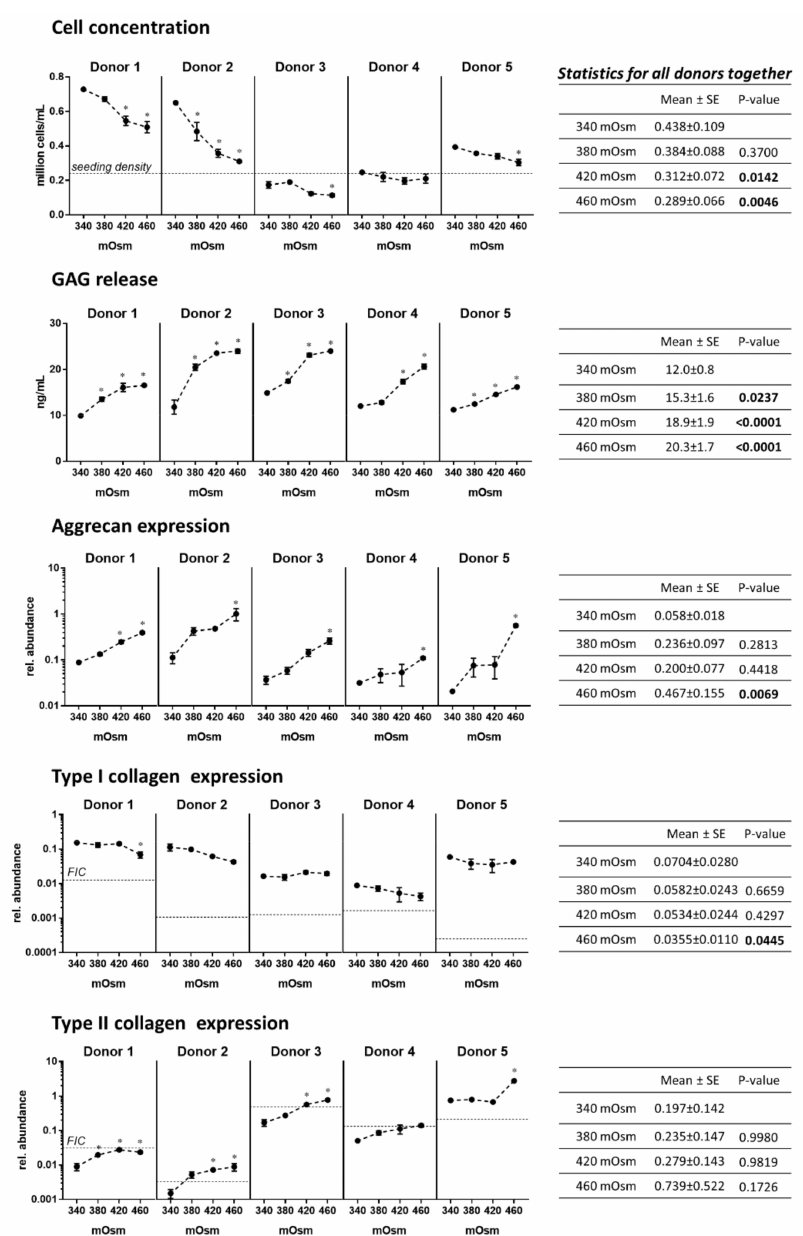
Figure 1. Human OA chondrocytes from five donors were cultured for six days in a monolayer at 340, 380, 420 and 480 mOsm. The cell concentration and the GAG release in the medium were measured (see Materials and Methods). Aggrecan, and type II and I collagen gene expression were evaluated by RT-qPCR. Data on the graphs represent the mean +/ - standard error of the mean of technical replicates ( n = 3–6). For the cell concentration, the seeding density is shown with a dotted line as well as the level of gene expression in freshly isolated chondrocytes (FIC) for type I and II collagen. Statistical analysis was performed for each donor separately (* means significantly di ff erent from 340 mOsm with p < 0.05) and for all donors together with the means, standard errors of the mean (SE) and p values for the comparison to 340 mOsm being tabulated on the right ( p values in bold when p ≤